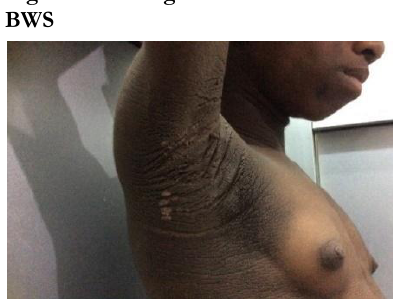
Figure 3: Acanthosis nigricans affecting neck and armpit in a child with